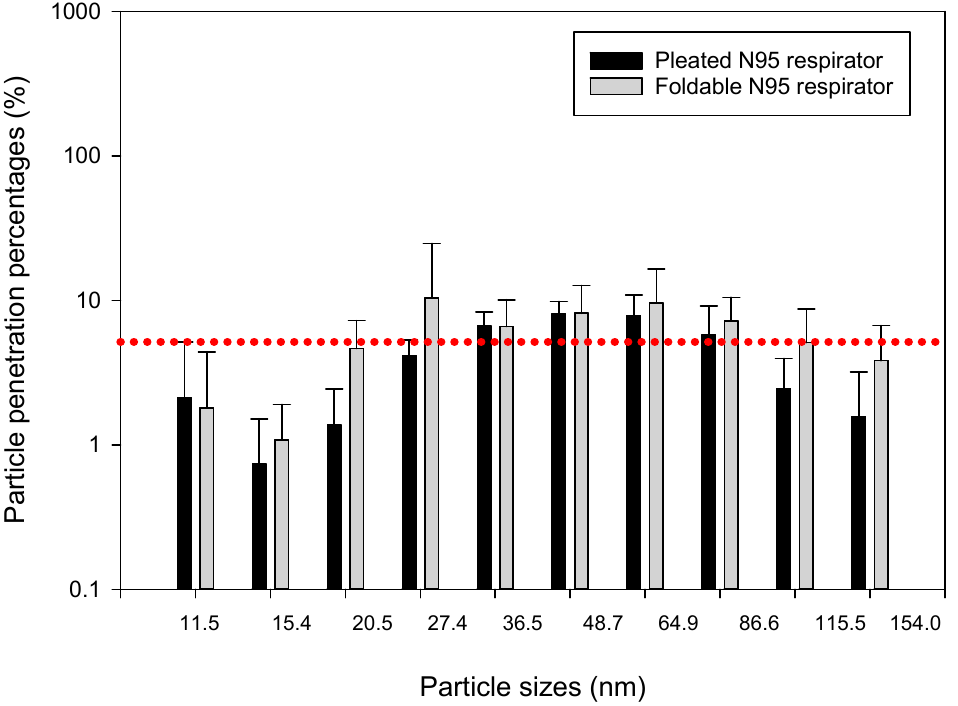
Figure 5. Penetration percentages of particles of 11.4–154.0 nm size range during wooden building frameworks construction. The dotted red line indicates the 5% particle penetration percentages, to be considered as the efficacy threshold for N95 respirators.